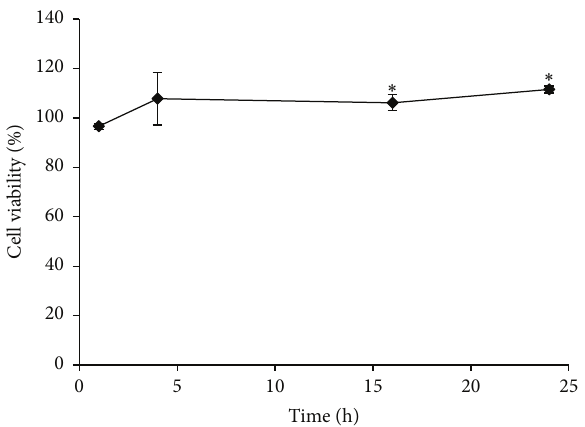
Figure5: Effectof TAT-Bcp1onH9c2 cell viability. Cellviability was determined using the MTT assay. The cells were cultured in normal growth medium and then treated with TAT-Bcp1 (10 𝜇 M) for 1h, 4 h, 16h, and 24 h. Cell viability was evaluated by measuring the 𝐴 570 nm ; the data are expressed as the mean percentages ± SD. compared to the control. ∗ 𝑝 < 0.001 ; the results were derived from four replicates of a representative experiment.